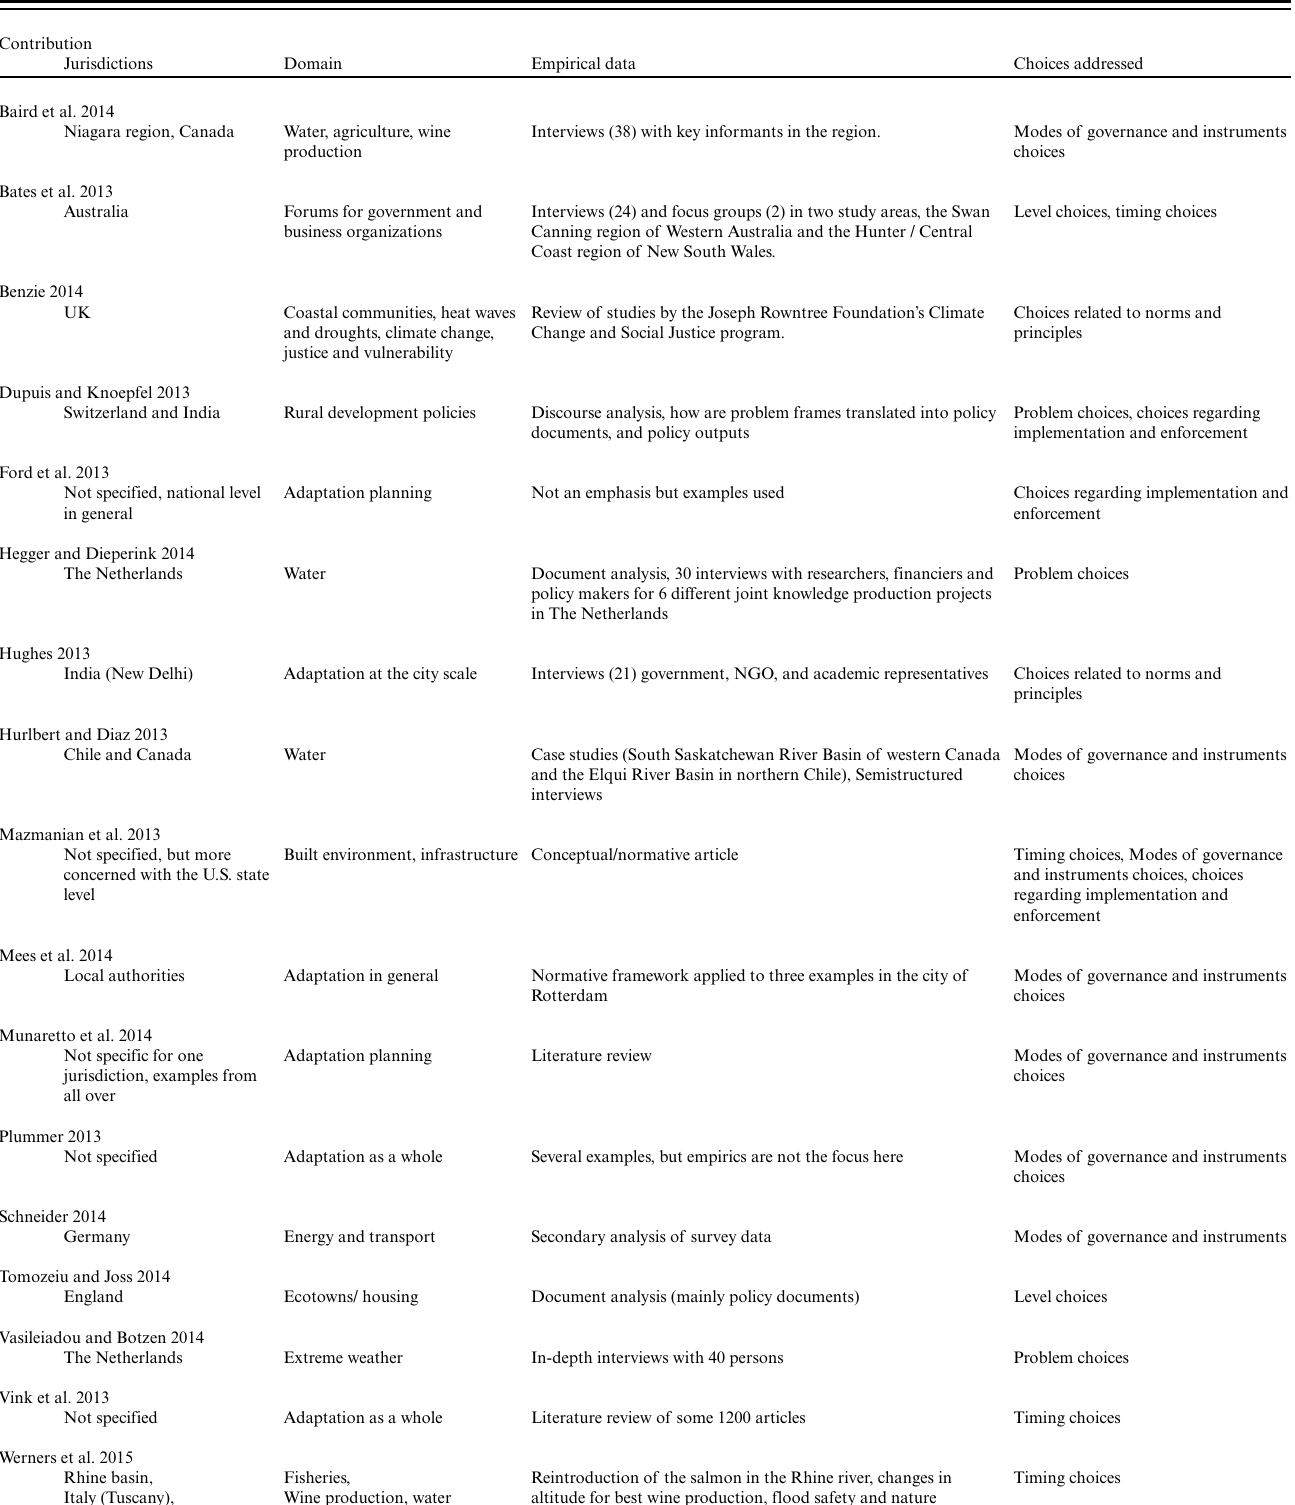
Table 1 . Governance domain and the choice of adaptation focus of contributions to the Special